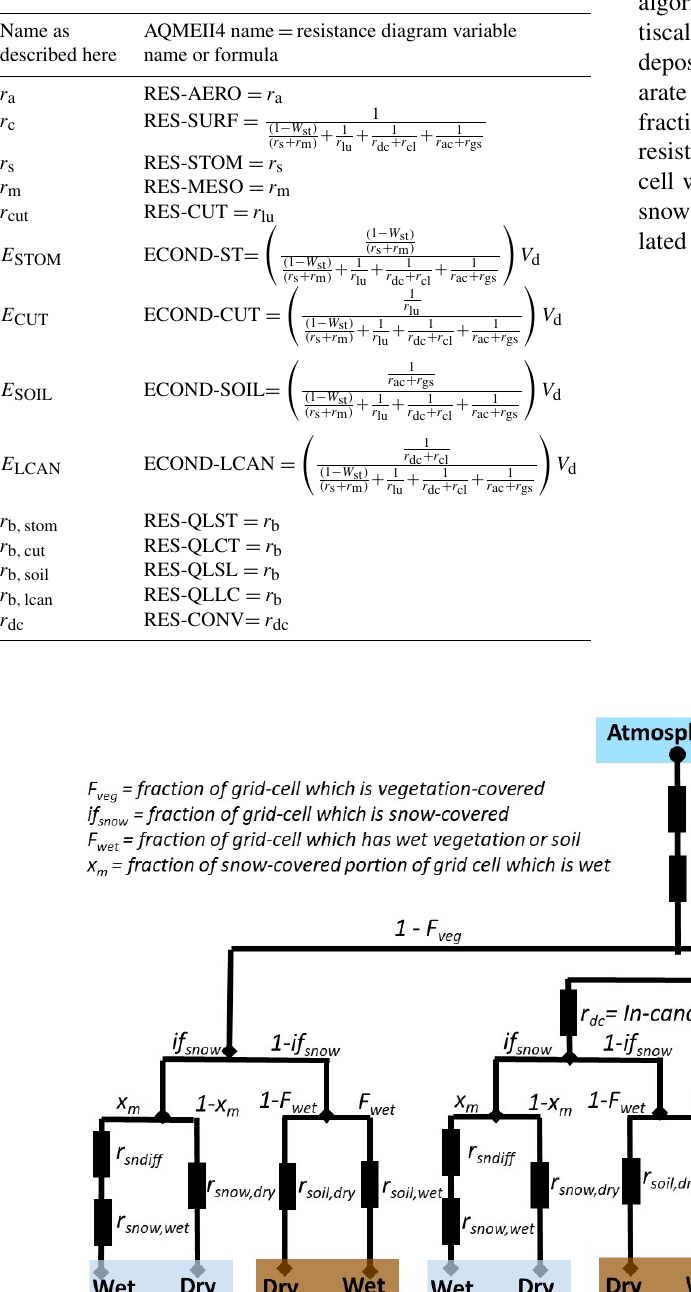
Table B1. Example 1: AQMEII4-reported gaseous deposition vari- ables corresponding to the GEM-MACH Robichaud resistance model of Fig. B1.